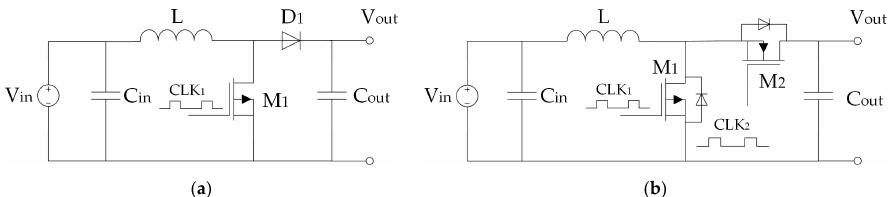
Figure 45. The asynchronous ( a ) and the synchronous ( b ) inductor-based boost converter.